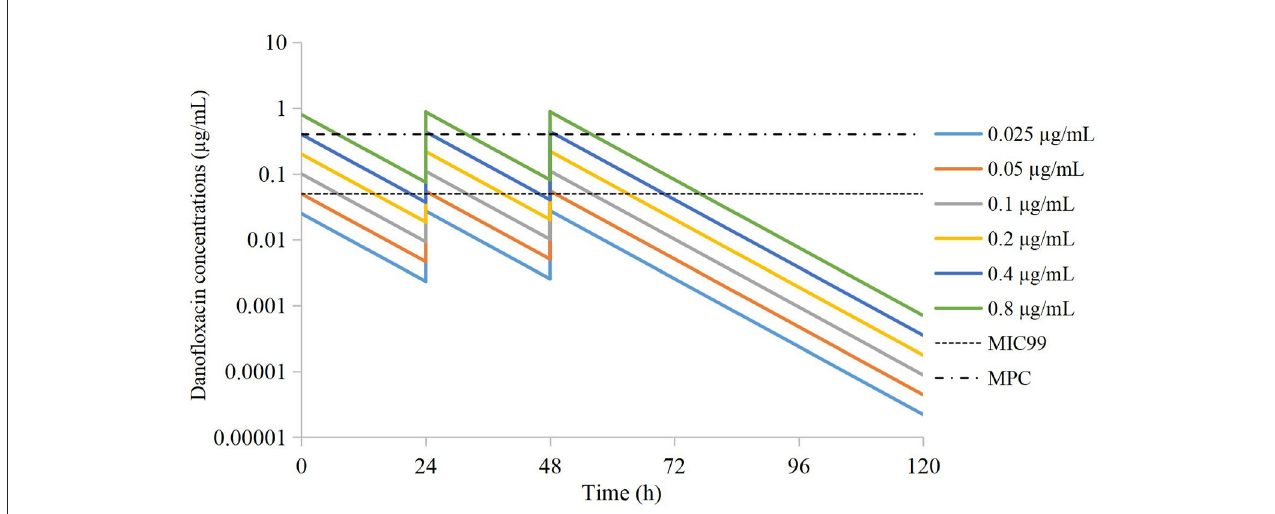
FIGURE1 Simulated time-concentration curves of danofloxacin in the peristaltic pump after extrapolation.